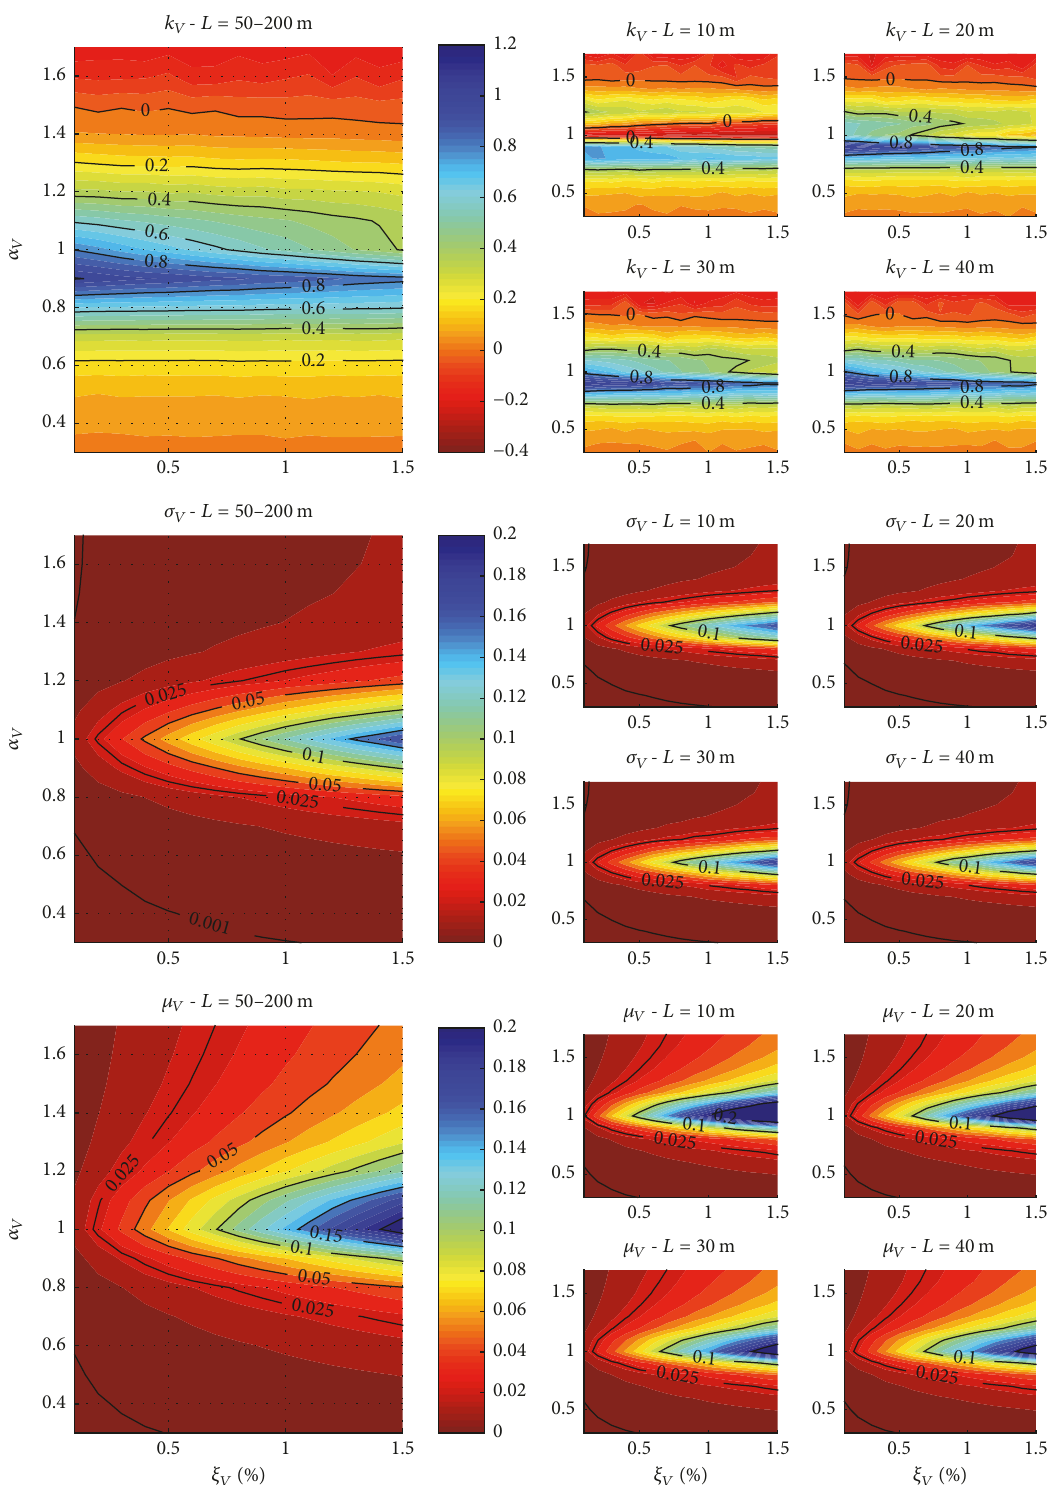
(𝜑 ( RL = 1,𝛼 ,𝐿,𝜉 )) : double clamped case in vertical 𝑉 𝑉 𝑉 𝑉 𝑉